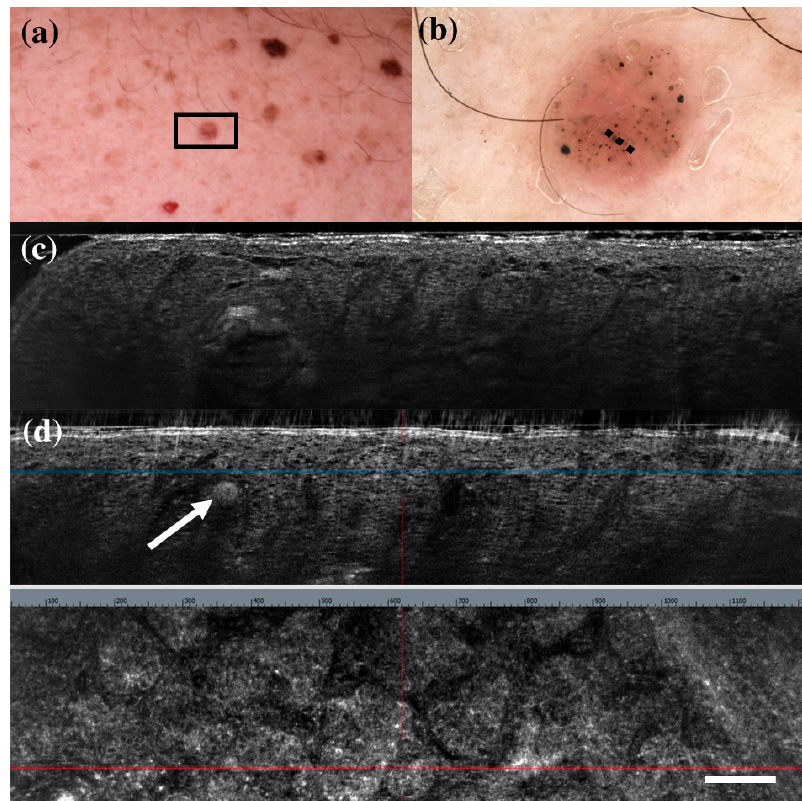
Figure 4. Trichoblastoma diagnosed as basal cell carcinoma under dermoscopy and line-field confocal